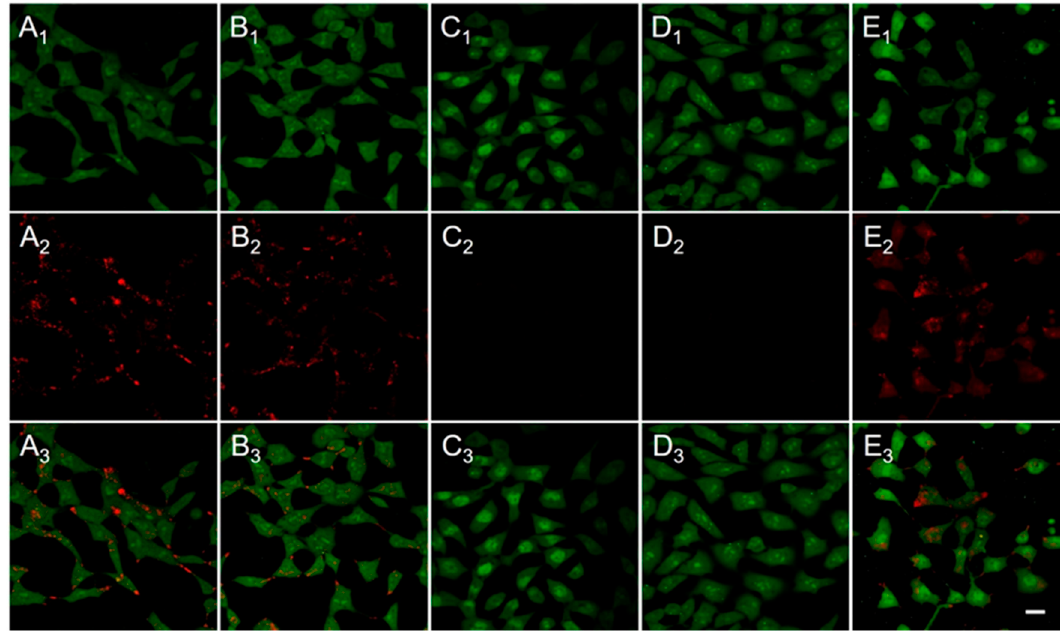
Figure 5. AO staining of cells treated with ( A ) AuNC; ( B ) pNLS/DNA/AuNC complexes; ( C ) AuNC + NIR irradiation; ( D ) pNLS/DNA/AuNC complexes + NIR irradiation and ( E ) pNLS/DNA/AuNC complexes + NIR irradiation + Vitamin C. The green fluorescent field for cytoplasm and nuclei (A 1 , B 1 , C 1 , D 1 and E 1 ), red fluorescent field for acidic organelles (A 2 , B 2 , C 2 , D 2 and E 2 ), and merged field of green and red fluorescent fields (A 3 , B 3 , C 3 , D 3 and E 3 ). Scale bar: 20 μ m. (Excitation at 488 nm; green channel: emission at 500–550 nm; red channel emission at 630–670 nm).